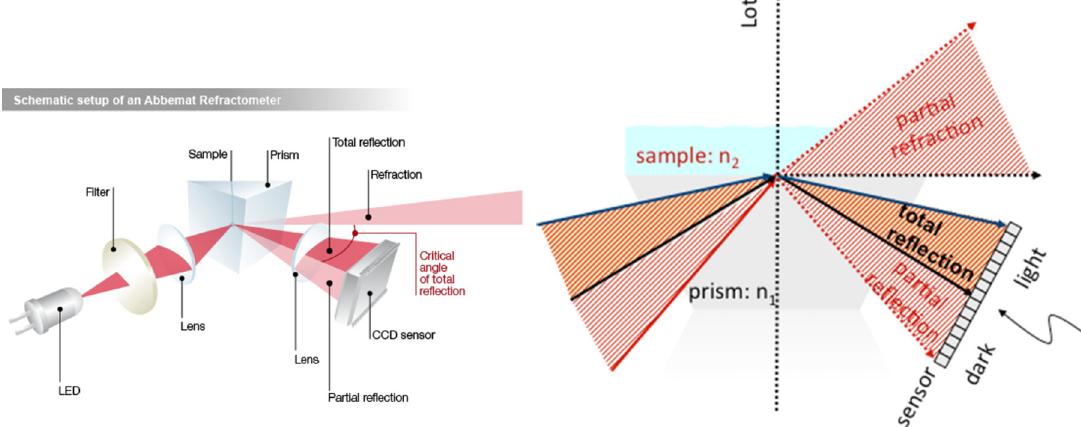
Fig. 2. Schematics setup of a